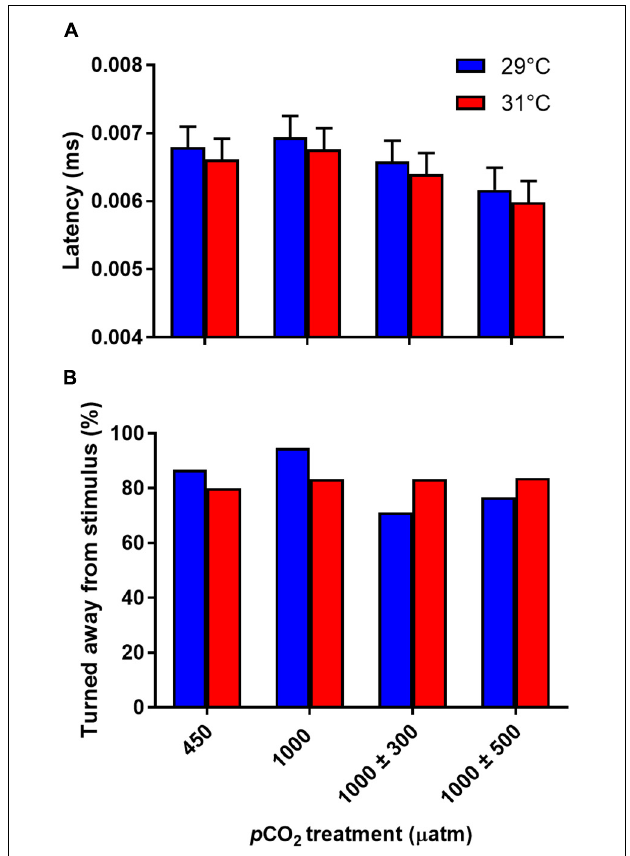
FIGURE 5 | Effects of elevated CO 2 and temperature on non-locomotor fast start traits of juvenile A. polyacanthus . (A) Response latency. (B) Direction turned. Bars represent means ±